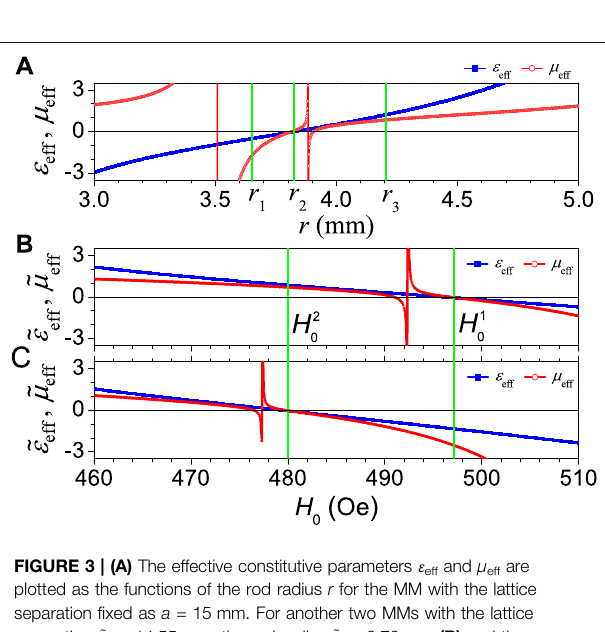
FIGURE 3 | (A) The effective constitutive parameters ε eff and μ eff are plotted as the functions of the rod radius r for the MM with the lattice separation fi xed as a = 15 mm. For another two MMs with the lattice separation ~ a 1 (cid:1) 14 . 55 mm, the rod radius ~ r 1 (cid:1) 3 . 78 mm (B) and the lattice separation ~ a 2 (cid:1) 12 . 25 mm, the rod radius ~ r 2 (cid:1) 3 . 58 mm (C) , ~ ε eff and ~ μ eff are plotted as the functions of a BMF H 0 . The BMF in panel A is H 0 = 500 Oe, and the operating frequency is f = 2.5 GHz, kept